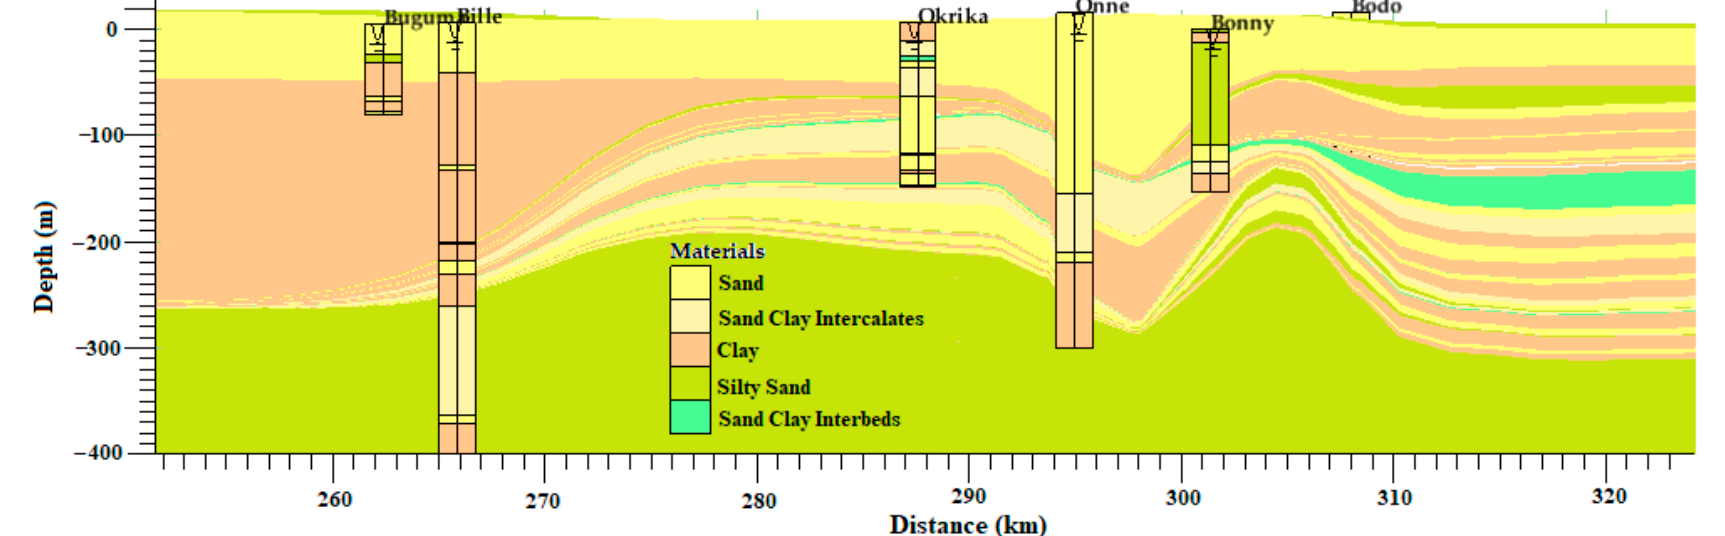
I at various zones within the Niger Delta